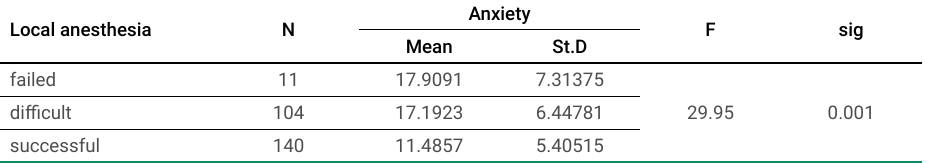
Anxiety F sig Mean